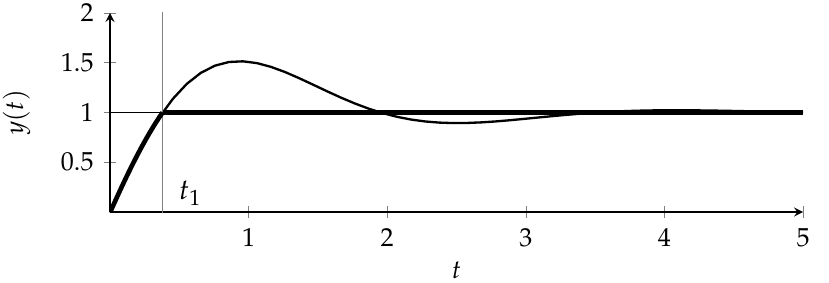
Figure 4. Illustration of a closed-loop flat response y under a reference change: (thin line) equivalent linear response, (thick line) resetted